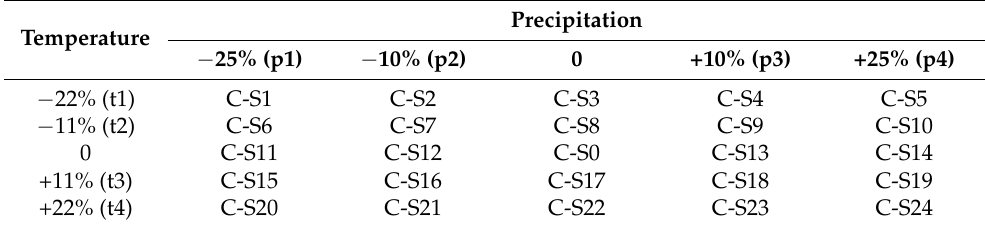
Table 2. Assumptions of climate change scenarios.